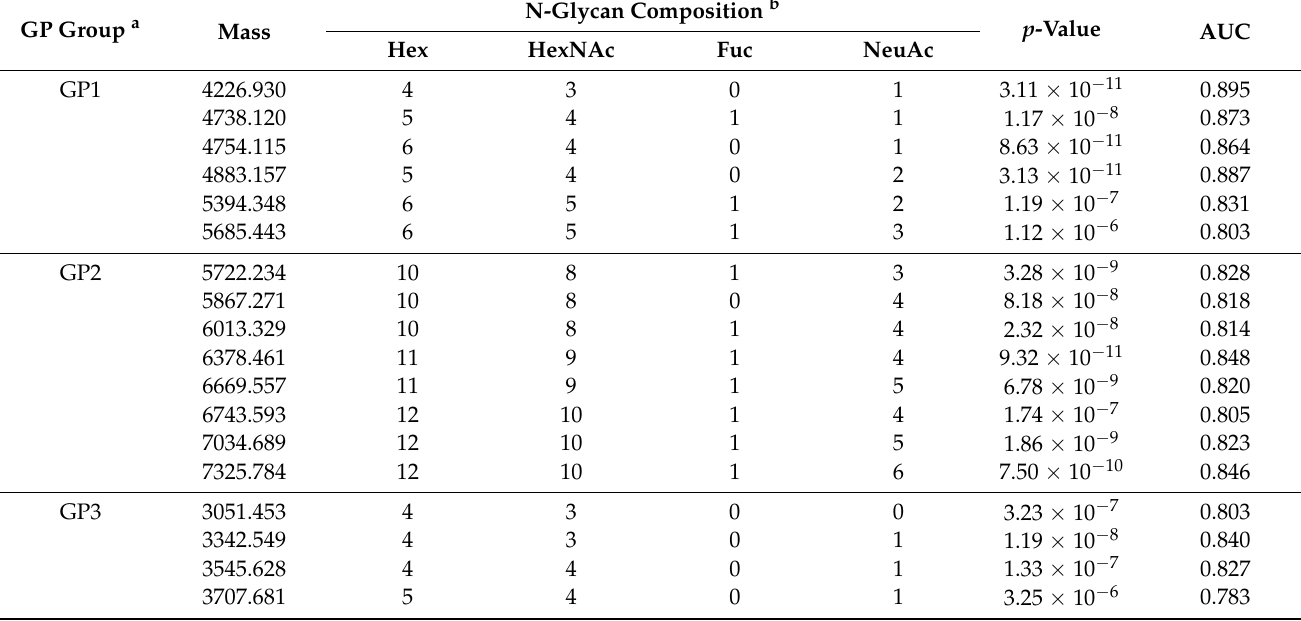
glycopeptides is included in Table